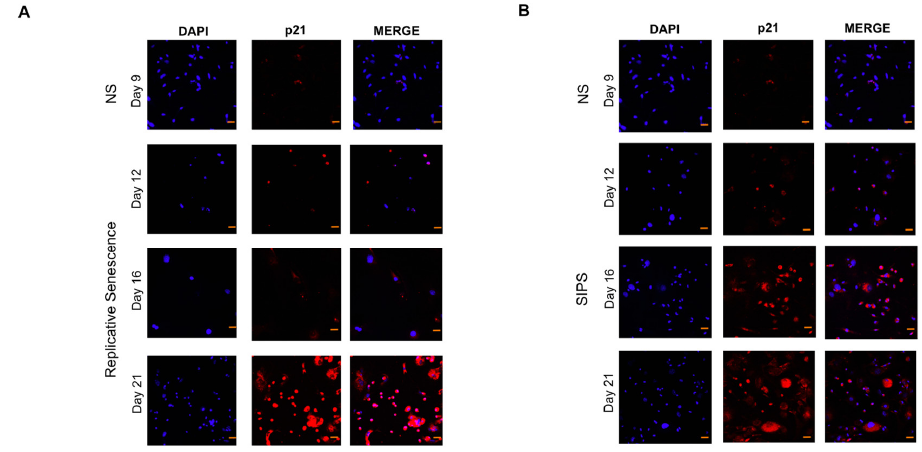
Figure 2. p21 immunofluorescence analysis. ( A ). The senescence marker p21 was assessed by immunofluorescence staining on days 9, 12, 16, and 21 on control fibroblasts to evaluate replicative senescence (RS): representative immunofluorescence, p21 (red) DAPI (blue). ( B ). The expression of the cell cycle inhibitor p21 was determined in H 2 O 2 -fibroblasts to evaluate stress-induced premature senescence (SIPS). Representative immunofluorescence, p21 (red) DAPI (blue). Images are 40× with a scale bar indicating 20 μM.